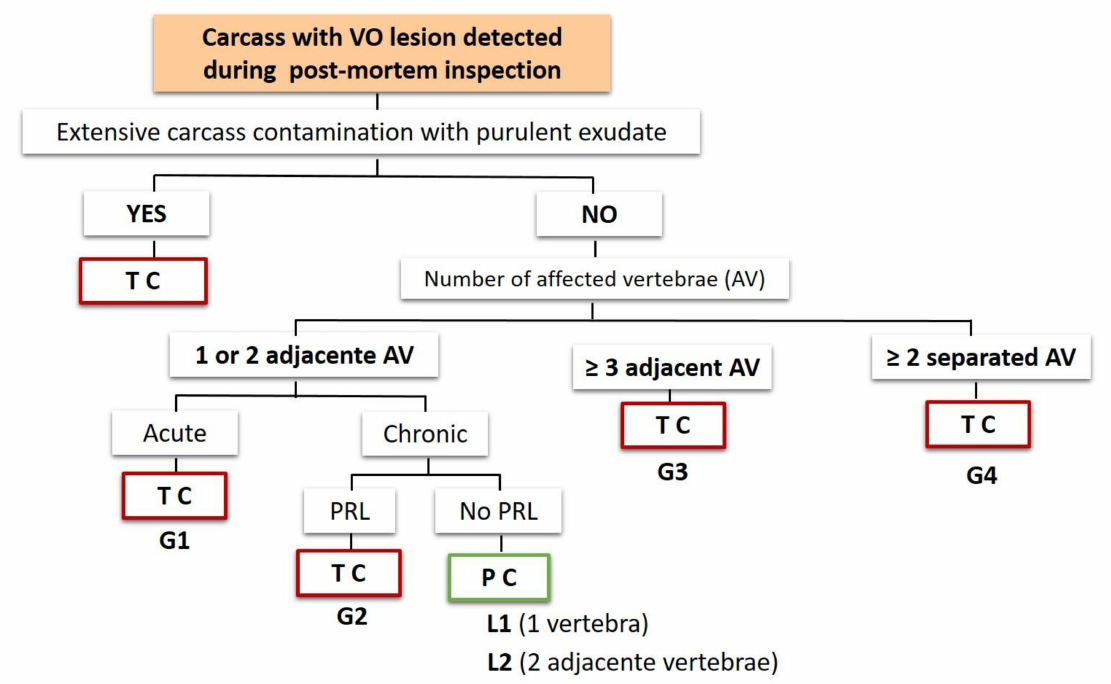
Figure 1. Initial scheme to classify VO cases as generalized (G) or as localized (L) cases. AV—a ff ected vertebrae; PRL—pyemia-related lesions; G1, G2, G3, G4—codes for di ff erent types of generalized cases; L1, L2—codes for di ff erent types of localized cases; TC—total condemnation; PC—partial